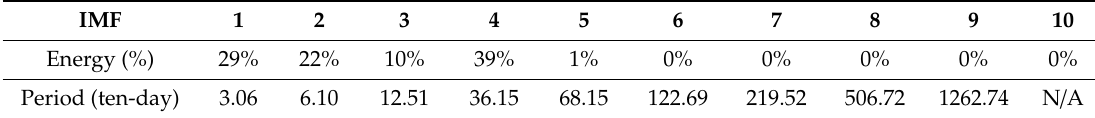
Figure 9. Weight of each IMF for a 60-year flow. Figure 10. Average period of each IMF for a 60-year flow.